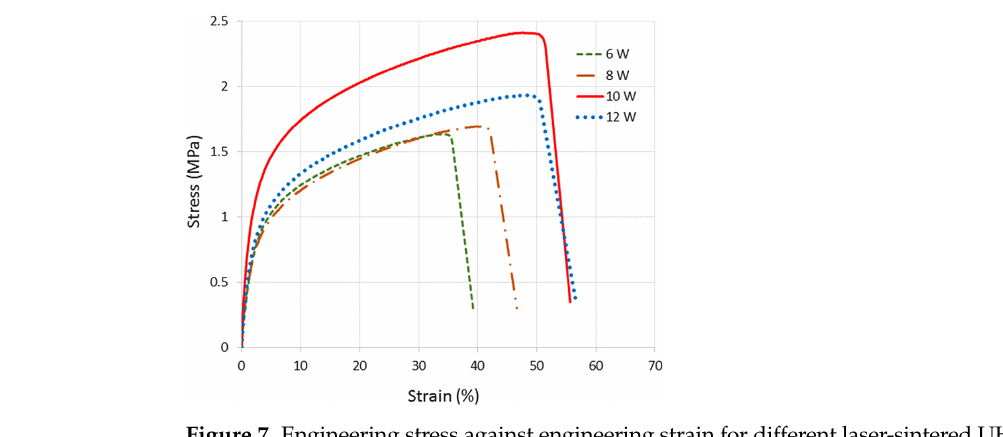
Figure 7. Engineering stress against engineering strain for different laser-sintered UHMWPE samples with laser powers of 6, 8, 10, and 12 W, respectively. Each profile constitutes the average of five samples tested under similar conditions. Reproduced with permission [117], Copyright 2016, EDP Sciences.